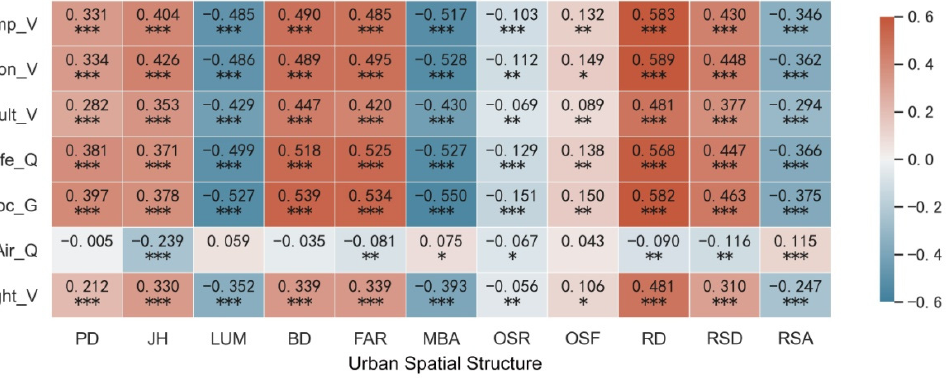
Figure 6. Binary spatial correlation between urban spatial structure and urban vitality. Note: *, **, and *** indicate pseudo p -value not greater than 0.05, 0.01, and 0.001.